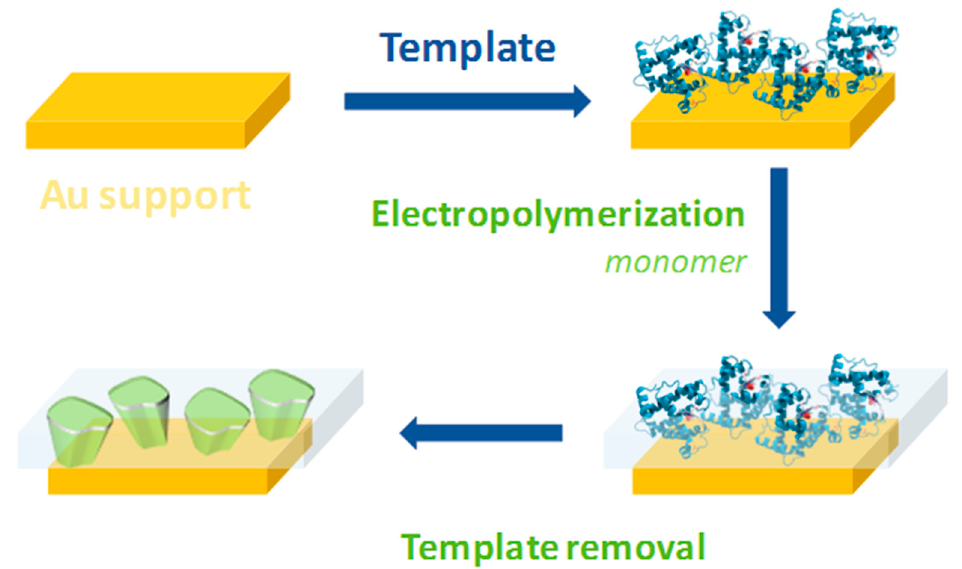
Figure 5. Electrosynthesis of MIPs.